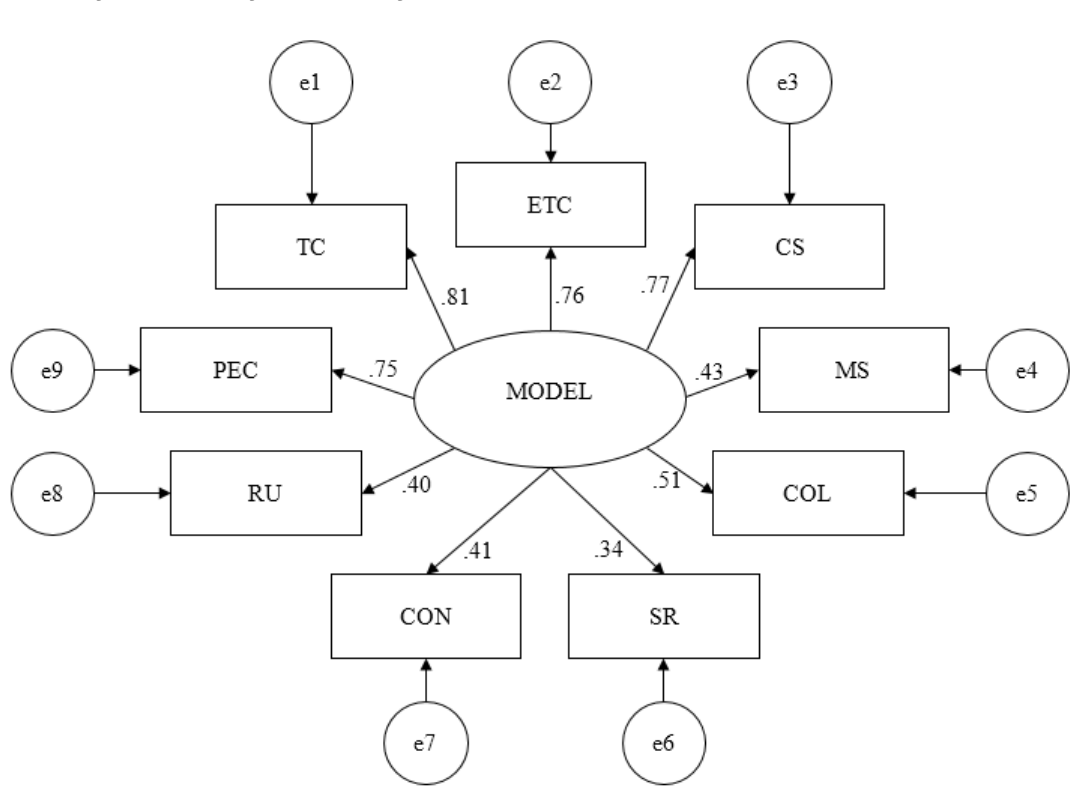
Confirmatory Factor Analysis Path Diagram